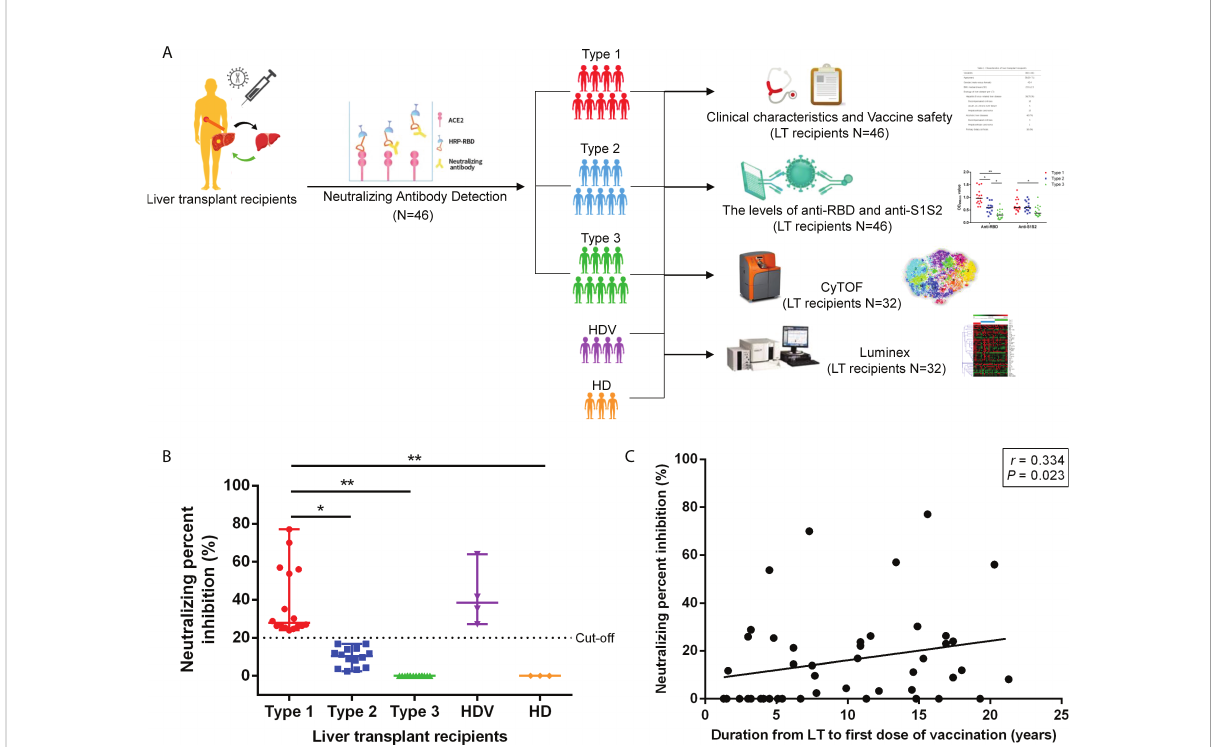
FIGURE 1 Schematic work fl ow and SARS-CoV-2 neutralizing antibody detection after vaccination. (A) Schematic description of LT recipient groups and blood sample experiments. (B) Neutralizing antibody detection in plasma of LT recipients after two-dose inactivated vaccination. Cutoff value equal to 20% signal inhibition. Neutralizing percent inhibition (NPI) of sample ≥ 20% indicated the presence of Anti-SARS-CoV-2 neutralizing antibodies, whereas NPI < 20% indicated the absence of neutralizing antibodies. (C) Correlation between the duration from LT to fi rst dose of vaccination and NPI. p -Values (two-sided) and r values are based on Spearman ’ s rank test. LT, liver transplant. *p < 0.05, **p <